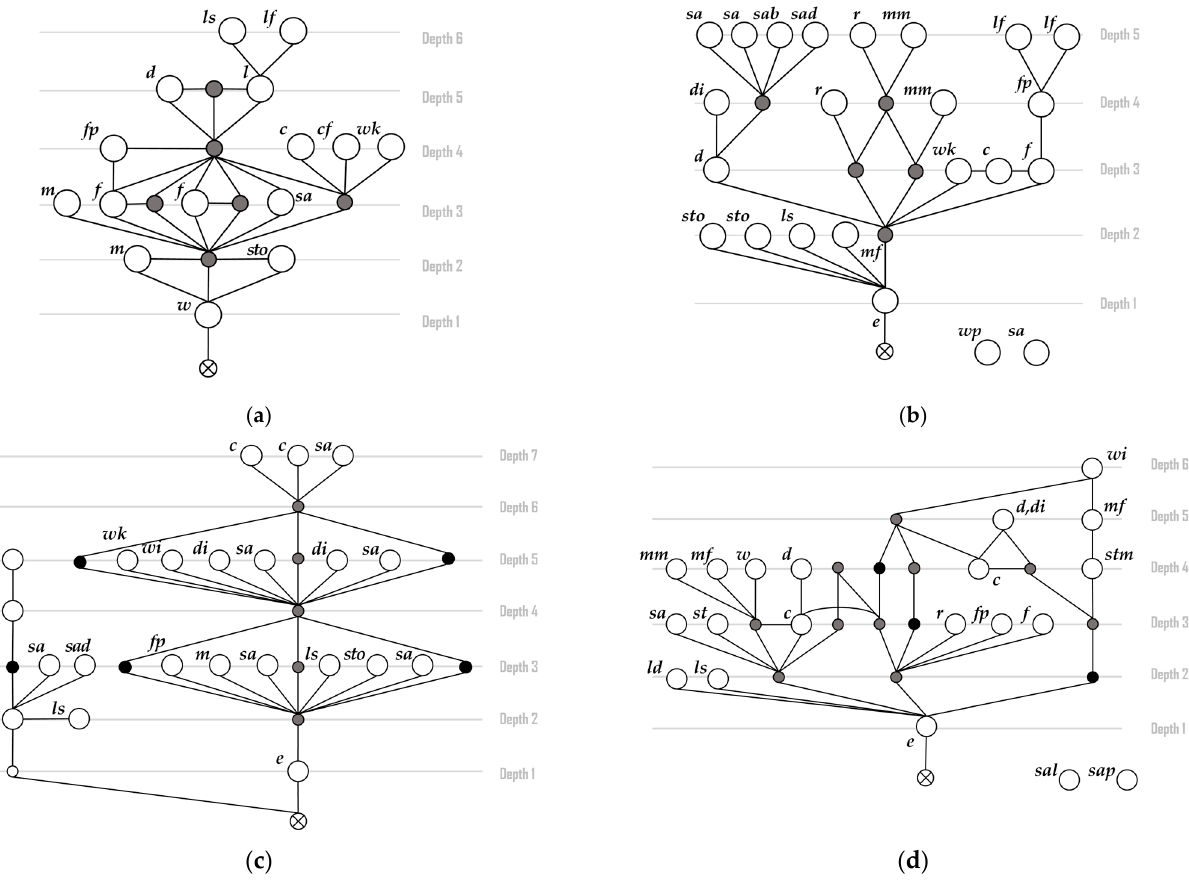
Figure 3. Justified graph analysis (see Figure 2 for key to room functions; black nodes indicate verticals, while grey nodes indicate corridors): ( a ) case 1 (U.S.); ( b ) case 2 (AU); ( c ) case 3 (JP1); ( d ) case 4 (JP2).